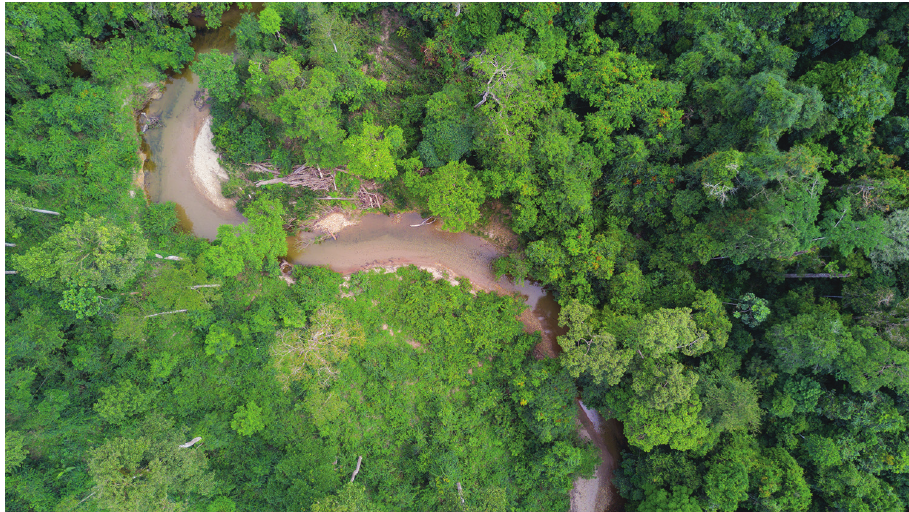
Figure 5. Habitat of Pyrophleps ellawi : sandy/pebble river banks in a lowland dipterocarp forest, Malaysia.